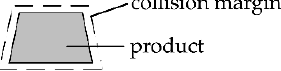
Figure 6. Collision margin applied by BulletPhysics.